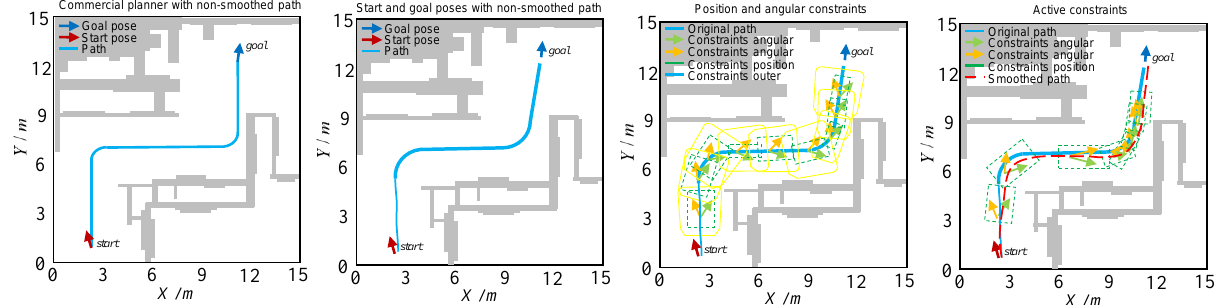
Figure 8. Path-smoothing step. Left : Given the start pose and target pose, a commercial motion planner computed the path. Middle left : Given a starting pose and a target pose, the motion planner calculated the path ˆ ξ . Middle right : Spatial constraint extraction. Position constraints (green box), angular constraints (orange and green arrows) and their spatial combination (yellow line) were computed for each ( ˆ x i , ˆ y i ) ∈ ˆ ξ . For clarity, the figure represents only a subset of state points ( ˆ x ) ∈ ˆ ξ . Right : Motion constraints drawn on a smooth i , ˆ y i